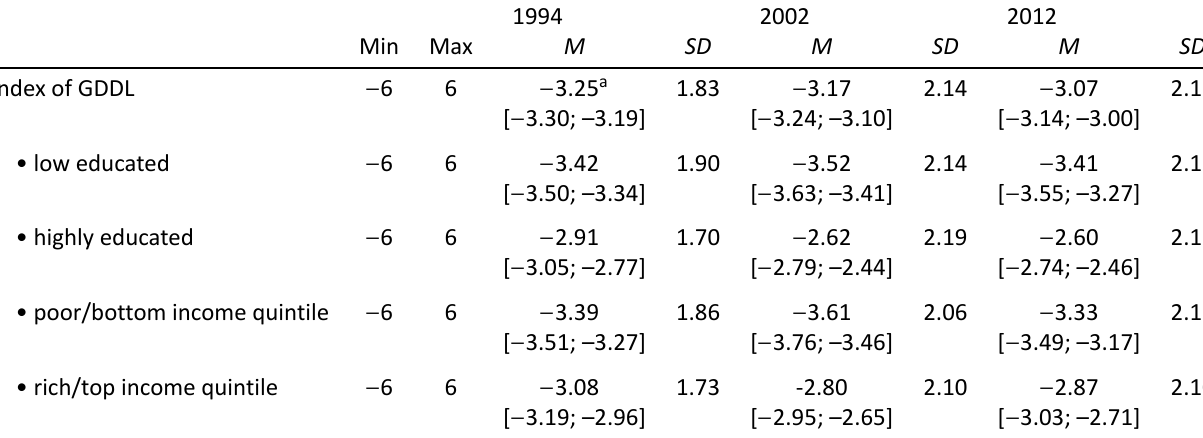
Table 1. Descriptive statistics, dependent variable, CEE Region (N =